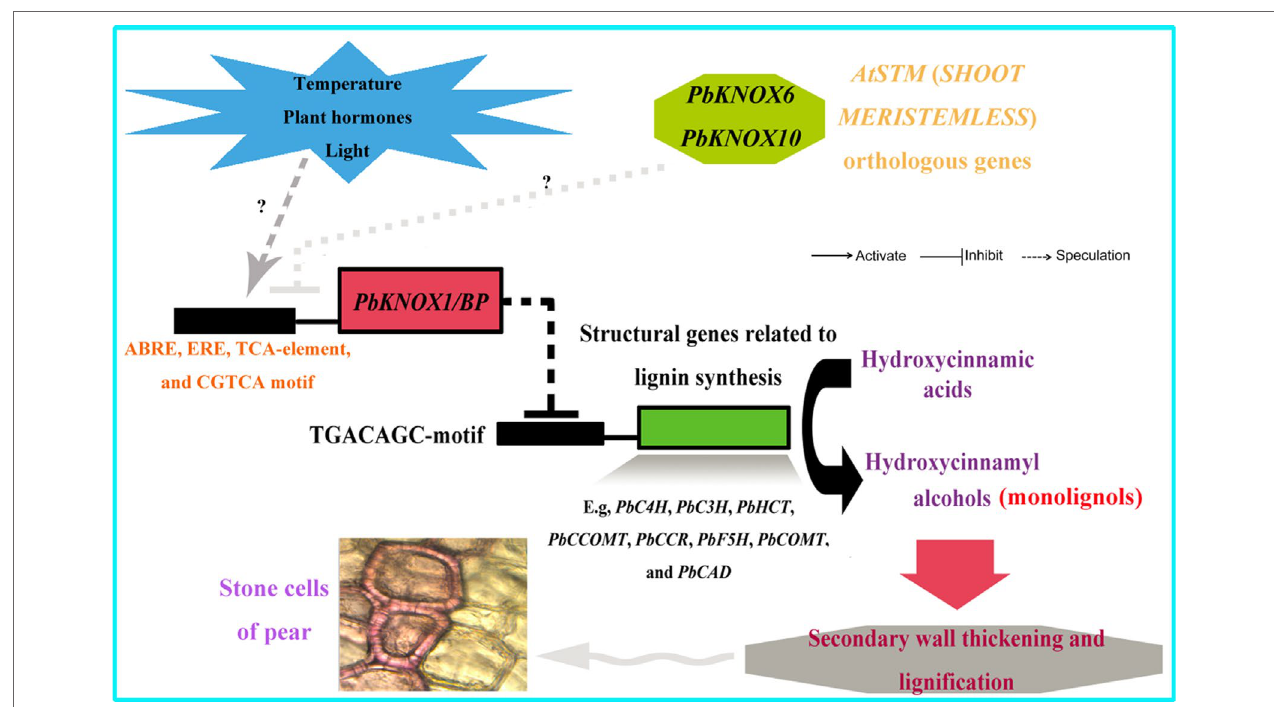
FIGURE 10 | Model depicting the proposed regulatory interactions of PbKNOX1/BP on pear lignin metabolism and stone cell development. T bar and arrow refer to negative and positive effect on downstream effector or biological process,